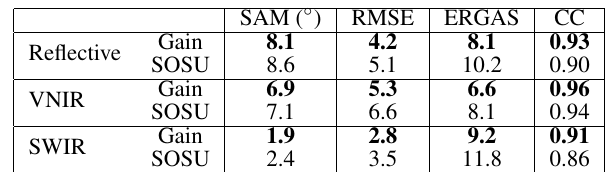
Figure 7. SOSU preprocessed image – localisation of each reorganisation